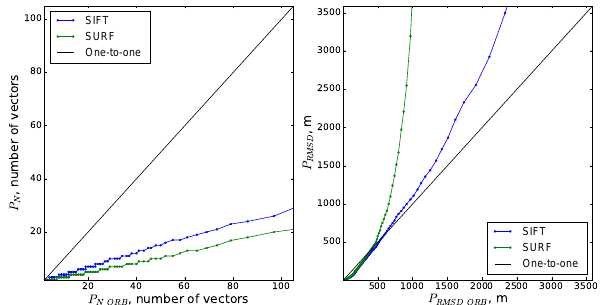
Figure 10. Q-Q plot of number of vectors N (left panel) and root mean square distance D (right panel) from results shown in Fig. 9. Tuned ORB algorithm ( x axis) compared to SIFT ( y axis, blue dots) and SURF ( y axis, green dots).